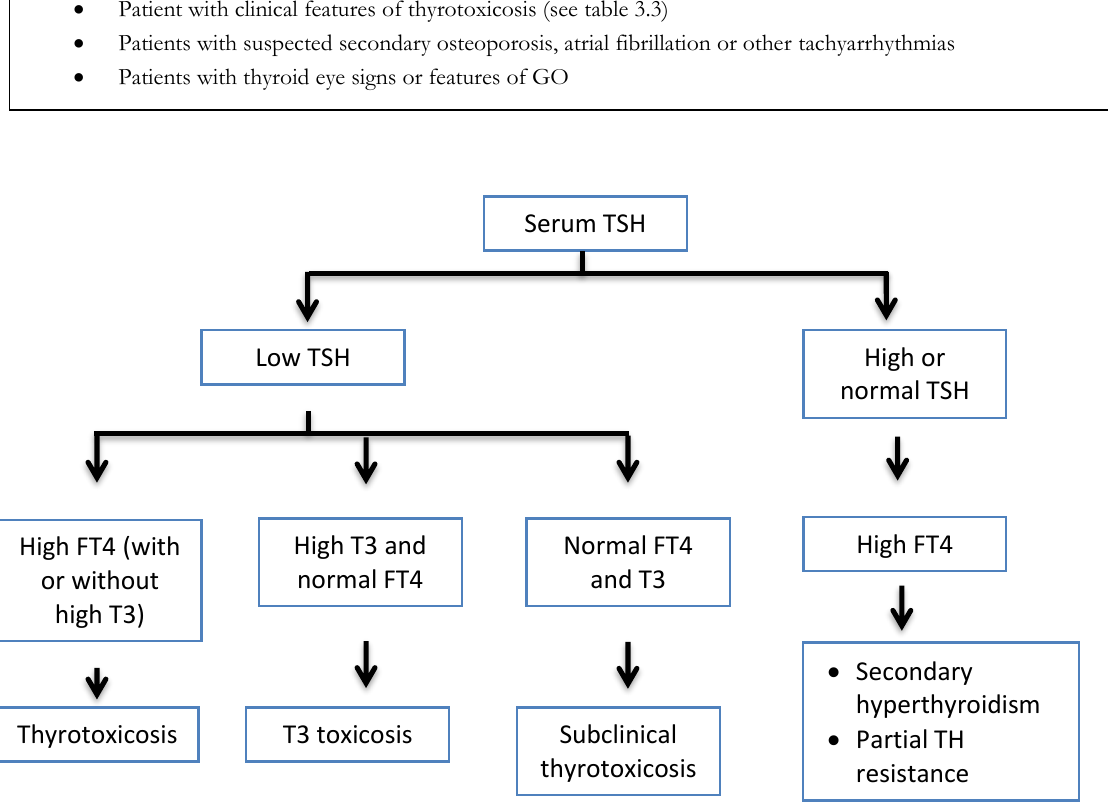
Figure 3.1. Interpretation of thyroid function test in patients with suspected thyrotoxicosis Note: Acute non-thyroid illnesses can cause a low normal TSH with low normal FT4. TFT should be repeated in few weeks after resolution of the